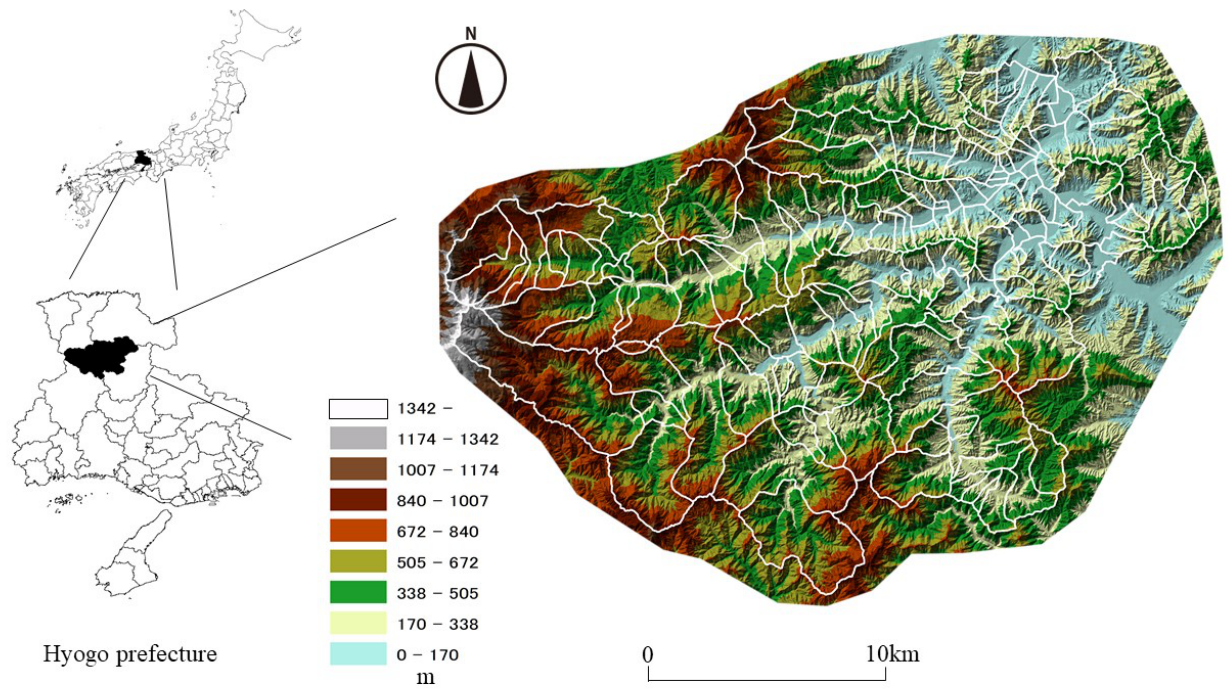
Figure 1. Location and topography of Yabu City and its agricultural community. In 2015, the average area of farmland per farmer in Yabu City was 0.41 ha, which was quite small compared with the national average at the time of 1.42 ha (Hyogo Prefecture: 0.62 ha) [20]. The proportion of subsistence farmers was also high at 59%, compared with 38% nationwide (Hyogo: 42%) [20]. The abandoned farmland rate (AFR) reached 23.5% in terms of area, which was much higher than the national average of 11.4% [20]. In terms of AFR by farmer type, the rate was higher for subsistence farmers (32.2%) and landholding non-farmers (62.3%) than for commercial farmers (8.2%) [20]. The national AFR for land- holding non-farmers was 31.1%; it is likely that more farmland abandonment occurred because farmers retired from farming due to small-scale and unfavorable conditions for agricultural production [20]. The average age of farmers was 61.9 years, which was higher than the national average of 60 years. In particular, 58.2% of farmers in Yabu City were over 70 years old. Since the national average for this age group was 46.9%, the farming commu- nity of Yabu City was considerably aged. The percentage of farm managers over 70 years old had reached 49.2%, which was likely to accelerate future farmland abandonment